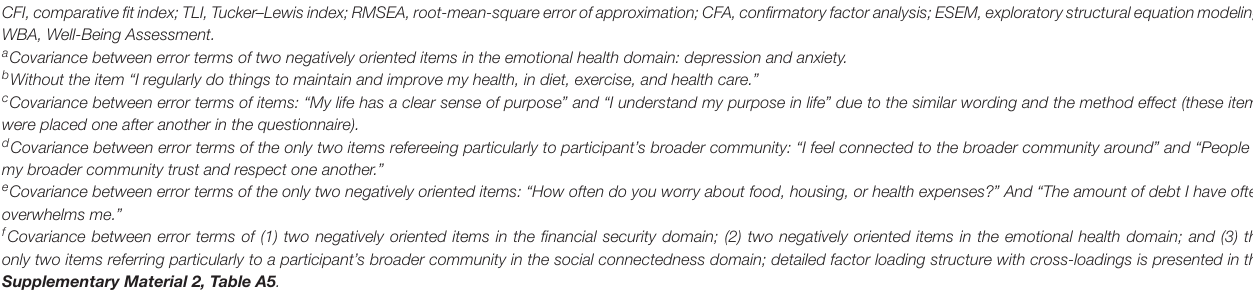
CFI TLI RMSEA [90%